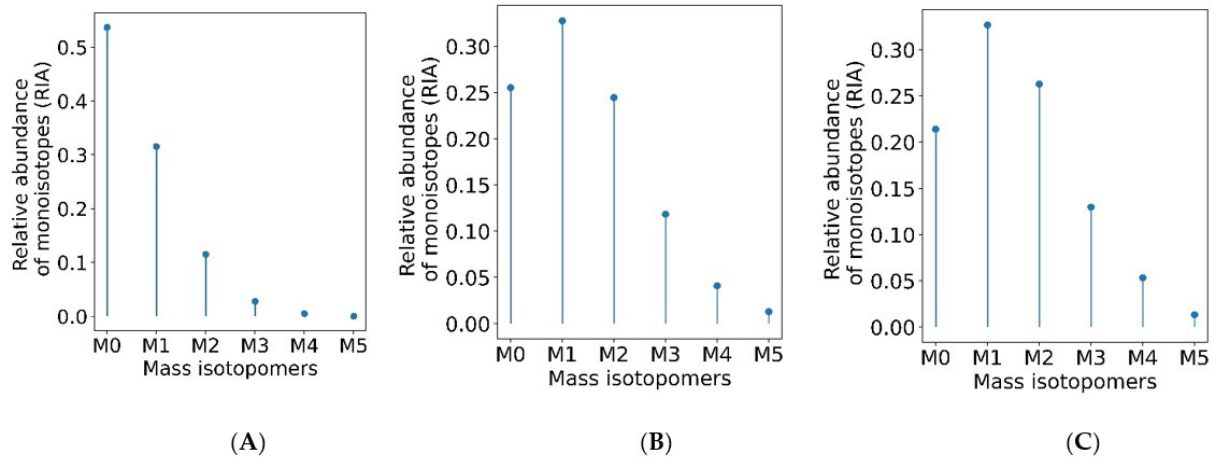
Figure 5. The monoisotopic RIA depletes with the labeling duration. Isotope profiles of SDEAVKPLGVK +2 peptide ( A ) from an unlabeled sample ( B ) from a labeled sample (day 7) ( C ) from a labeled sample (day 31).